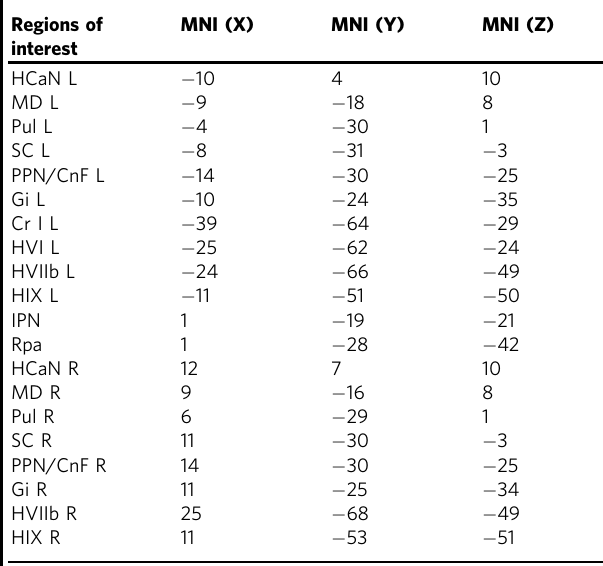
Table 2 MNI coordinates of the DAN subcortical regions ’ centers of gravity.